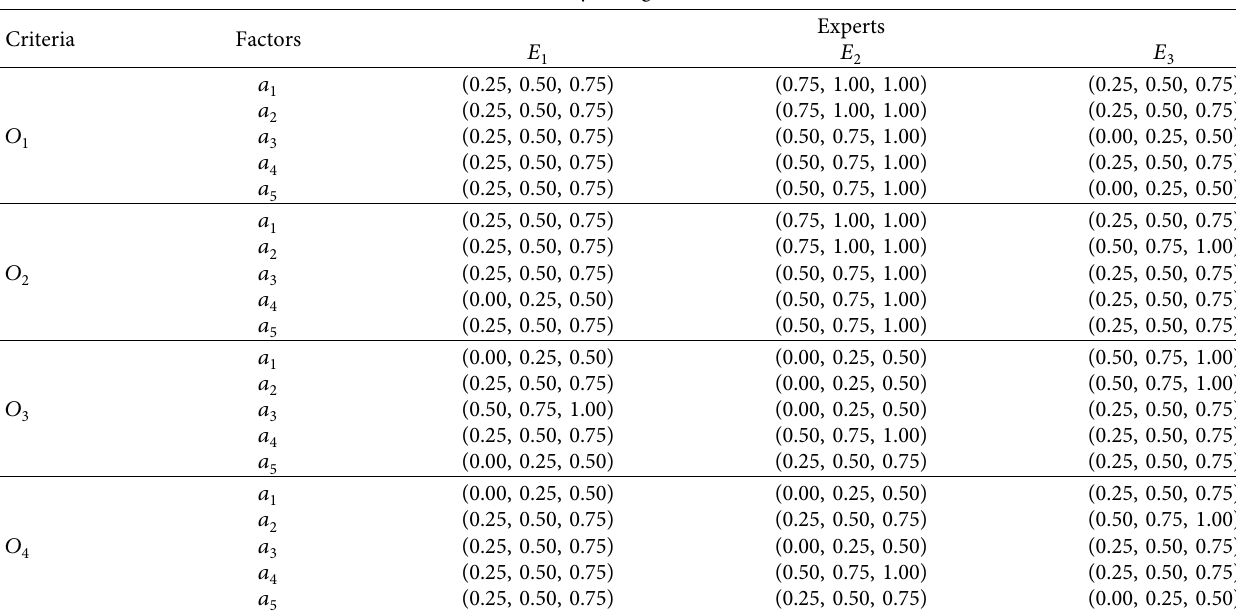
Table 7: Fuzzy ratings of the